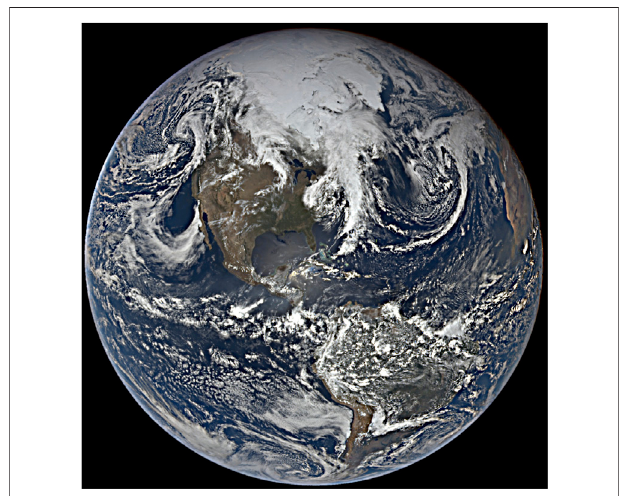
FIGURE 1 | EPIC RGB image corresponding to 2020-05-01 17:54:31 UTC. The image has been enhanced to show the cloud coverage in detail.